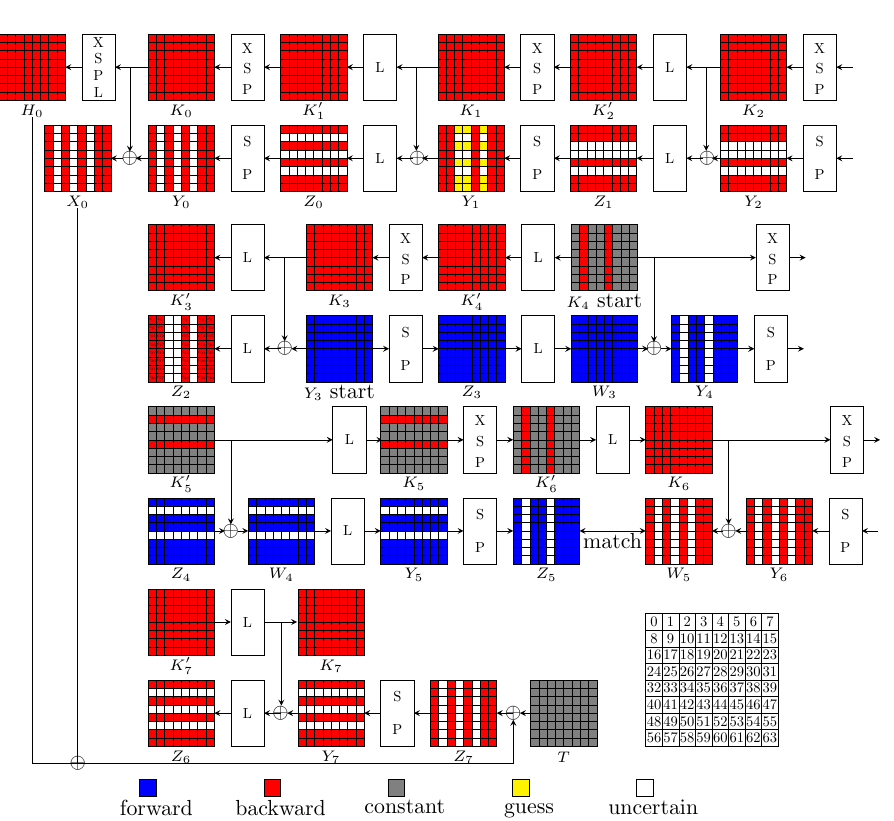
Figure 11: 7.5-round preimage attack on Streebog-512 compression